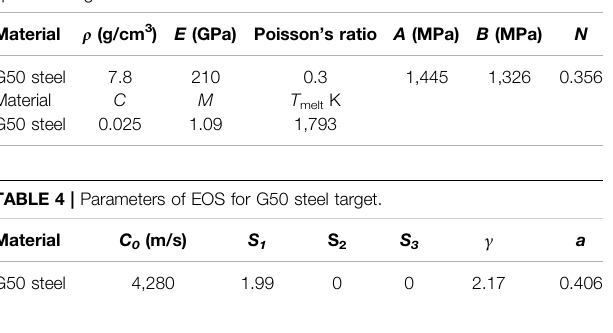
TABLE 3 | Constitutive properties for the G50 steel target and tungsten alloy spherical fragment.